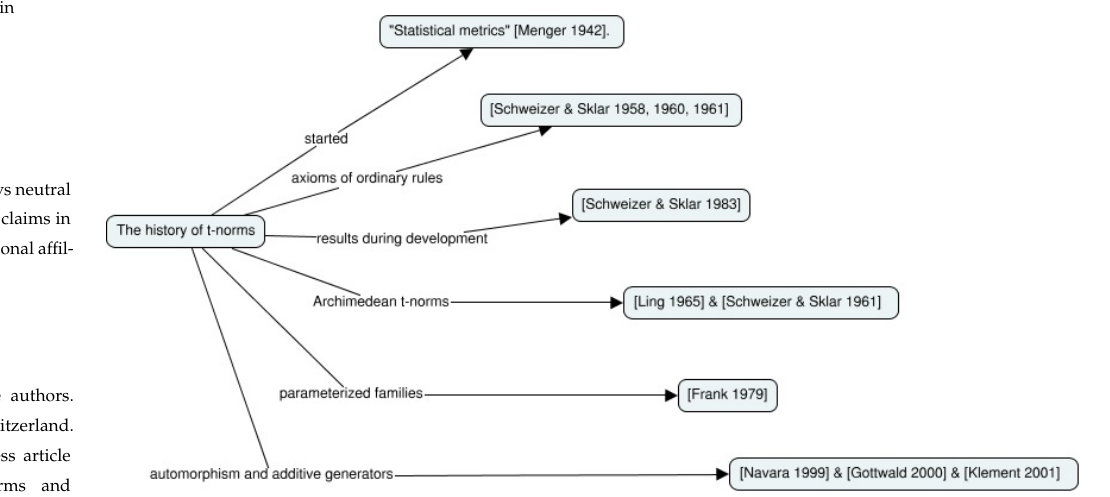
Figure 1. The history and evolution of